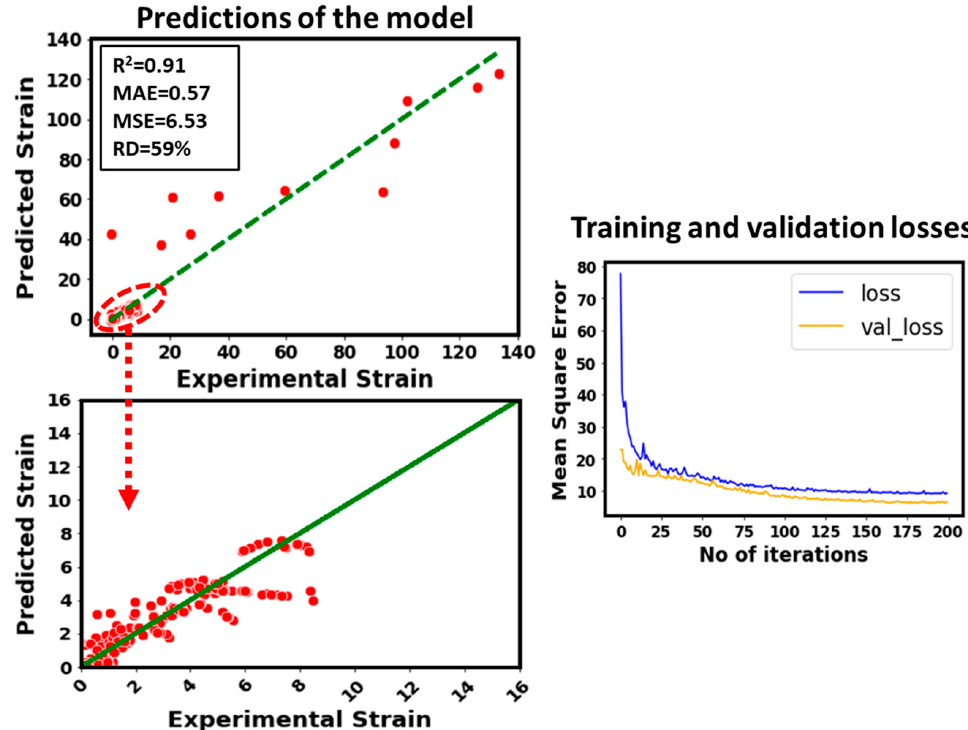
Figure 9. Predictive performance of the developed model by removing lattice dimensions (breadth, width, and total height) from the inputs.